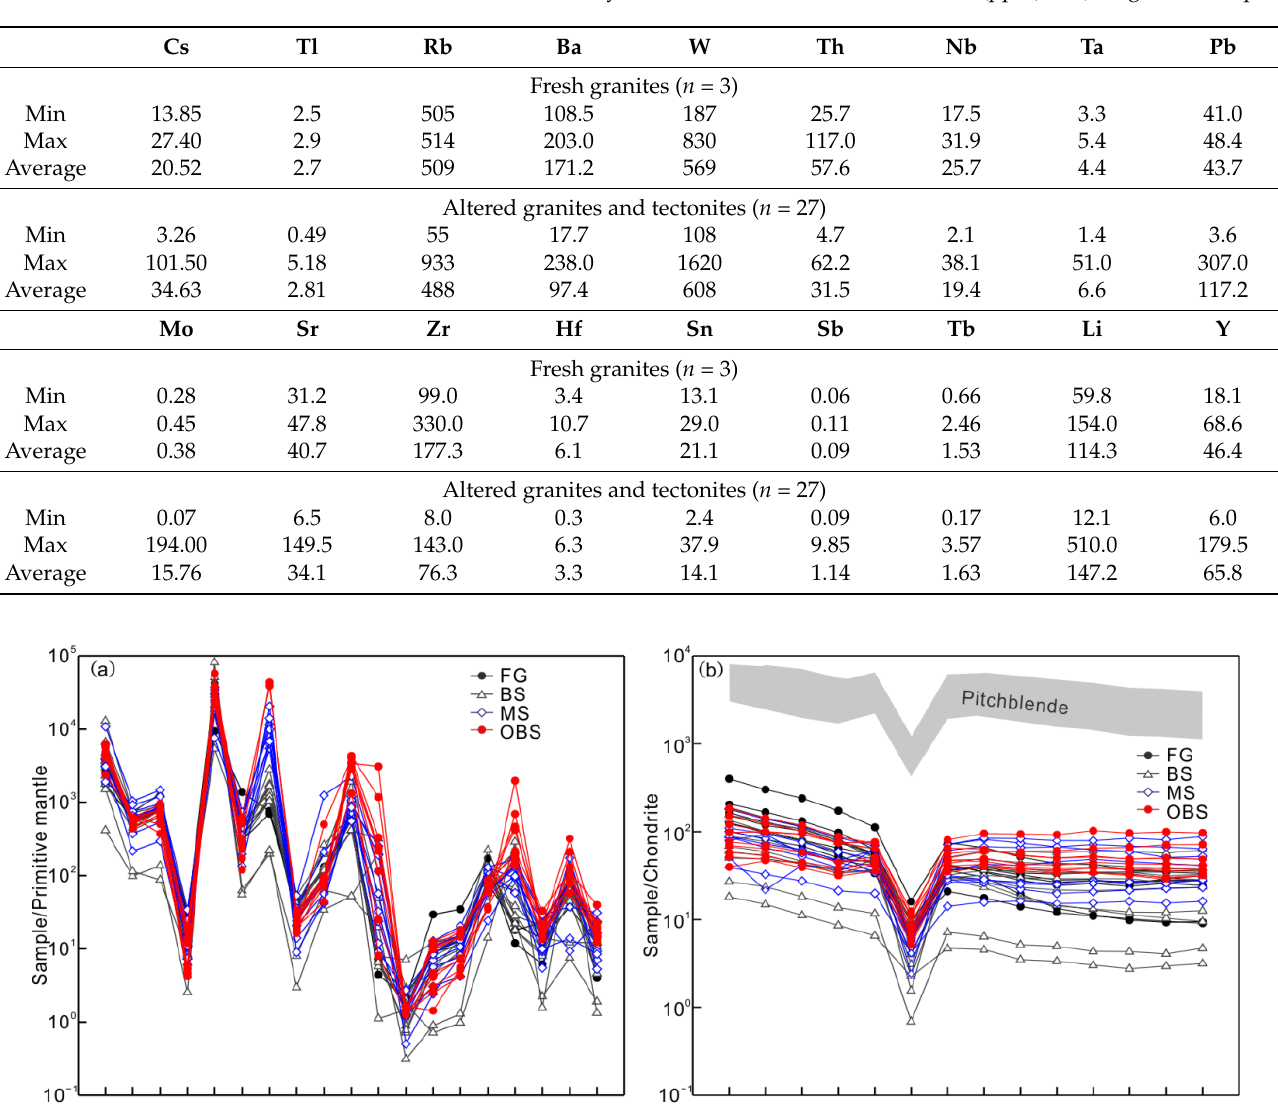
Table 3. Geochemical summary of selected trace elements and REEs (ppm) of SJOF granite samples.